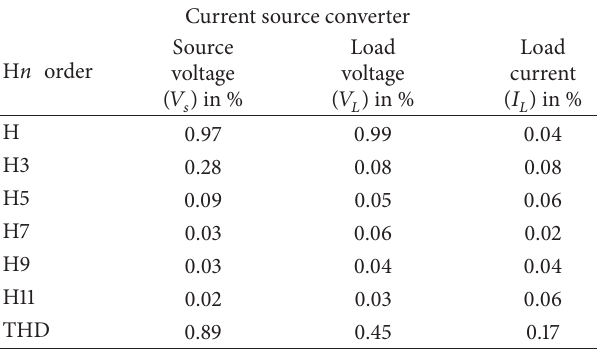
Table 1: Total harmonics distortion (THD in